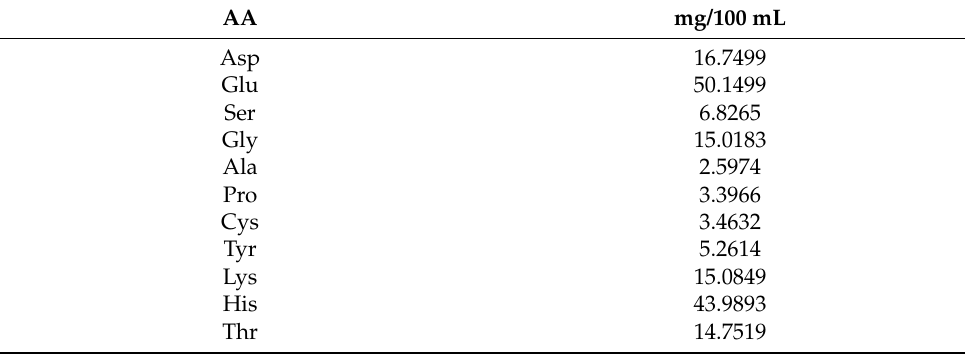
Table 3. Amino acid content present in bone broth obtained from bovine